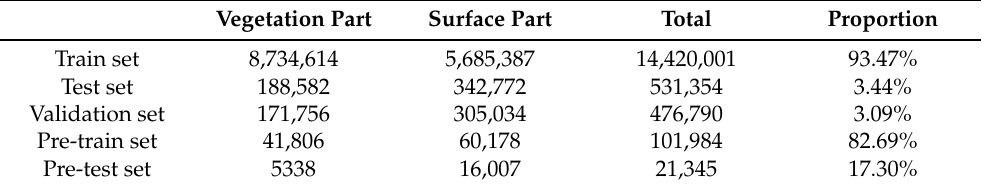
Figure 4. Top: View of the region under consideration. Bottom left: Visualization of the point cloud with the software CloudCompare. Bottom right: Results of the manual labeling (red: non-ground, blue: ground). Table 3. Data division.